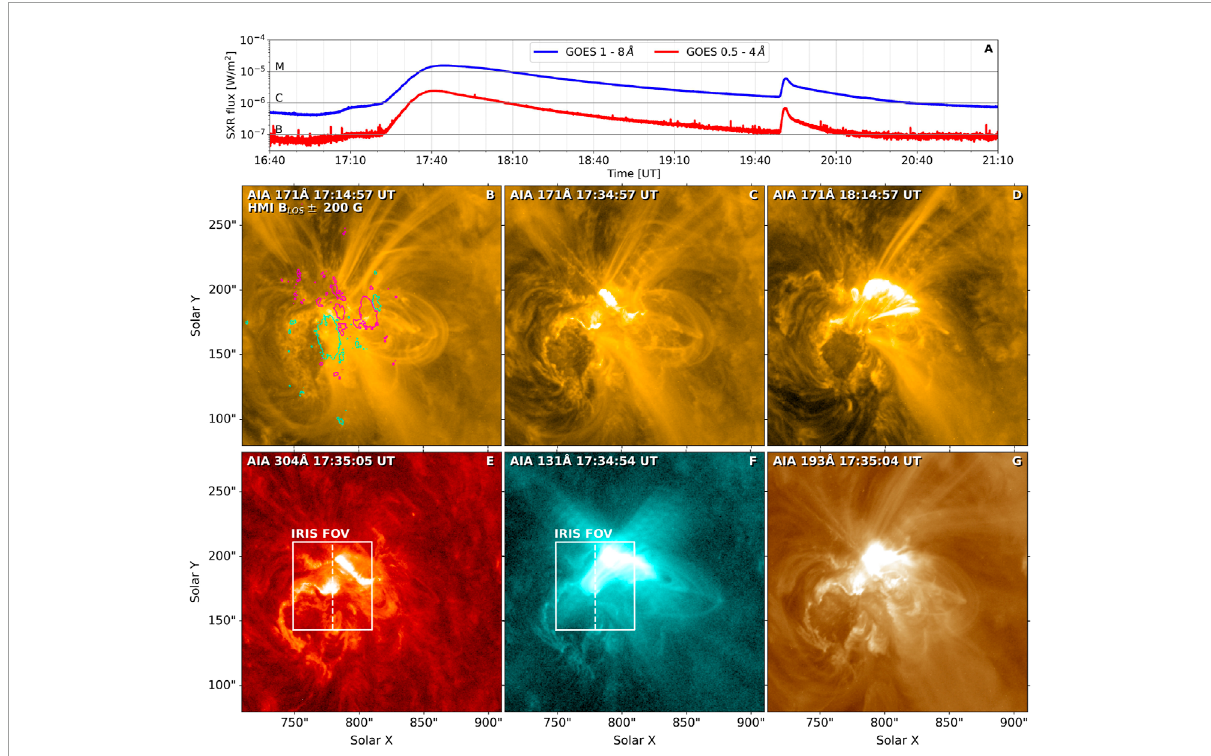
FIGURE 1 Context observations of the 18 January 2022 flare. Panel (A) displays the evolution of the soft X-ray flux measured in the 0.5–4Å (red) and 1–8Å (blue) channels of the GOES satellite. Imaging observations of the flare in AIA 171Å during the onset, impulsive, and gradual phases of the flare is shown in panels (B–D) . The bottom row of the figure details the flare during its impulsive phase. Panel (E) shows flare ribbons observed in AIA 304Å. Panels (F) and (G) detail hot flare emission as observed in AIA 131Å and AIA 193Å,